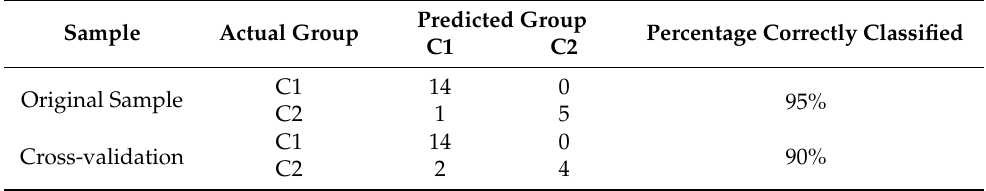
Table 6. Classification